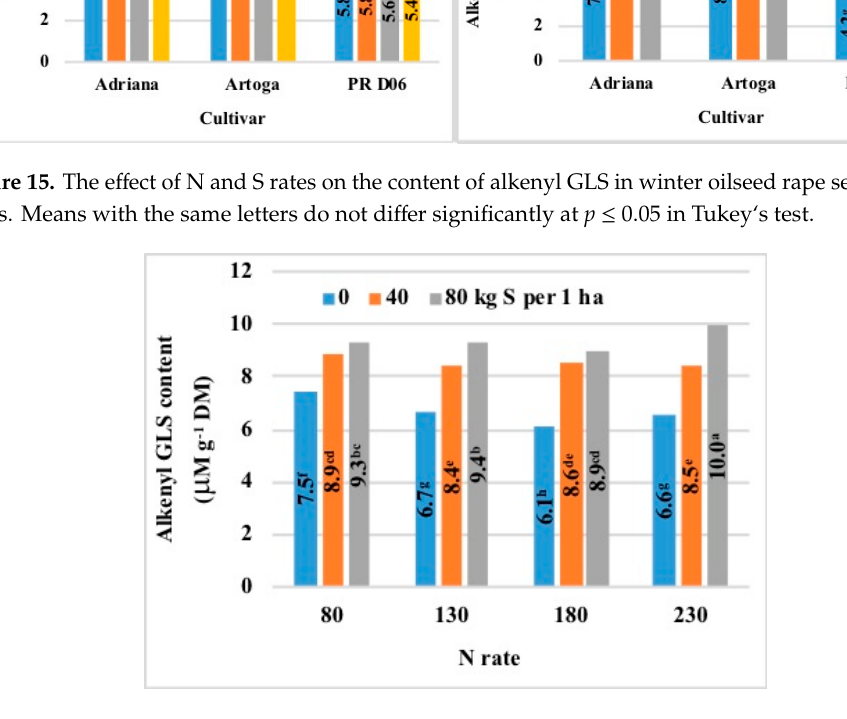
Figure 16. The relationship between N and S rates vs. the content of alkenyl GLS in winter oilseed rape seeds, across years. Means with the same letters do not di ff er significantly at p ≤ 0.05 in Tukey‘s